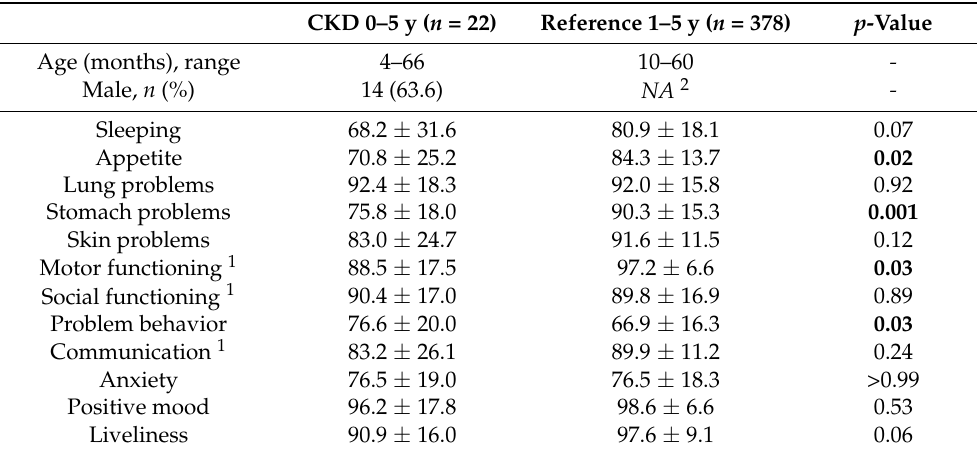
Table 2. Scores per subdomain of the TAPQOL. Scores are presented for CKD patient and reference group (general population) aged 0–5 years (proxy-report). Significant differences are shown in bold. CKD = chronic kidney disease; NA = not available; and SD = standard deviation.